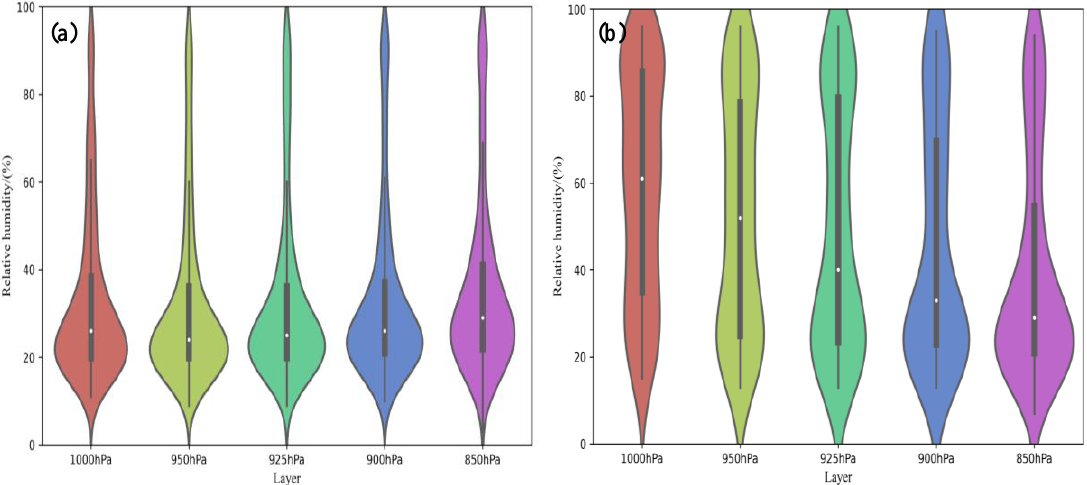
Figure 5. Observations of the relative humidity during the clean days ( a ) and polluted days ( b ).